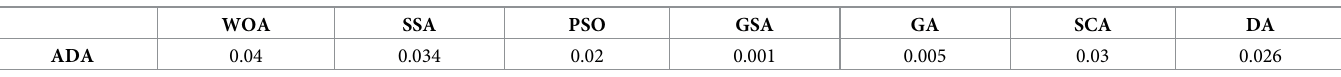
Table 6. p -values of the Wilcoxon rank-sum test in terms of average of benchmark